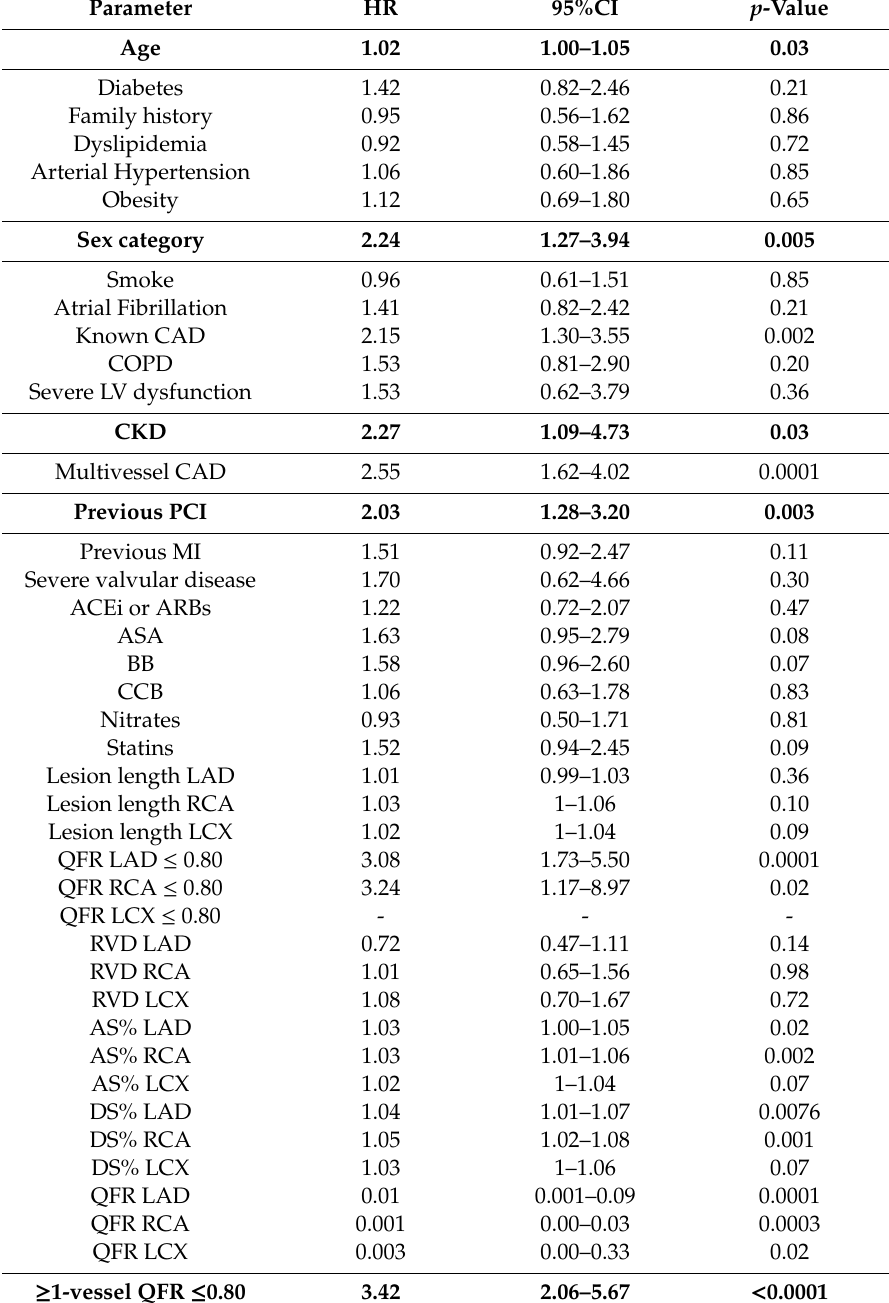
Table 3. Long-term MACCE (major adverse cardiovascular and cerebrovascular events) predictors at univariate